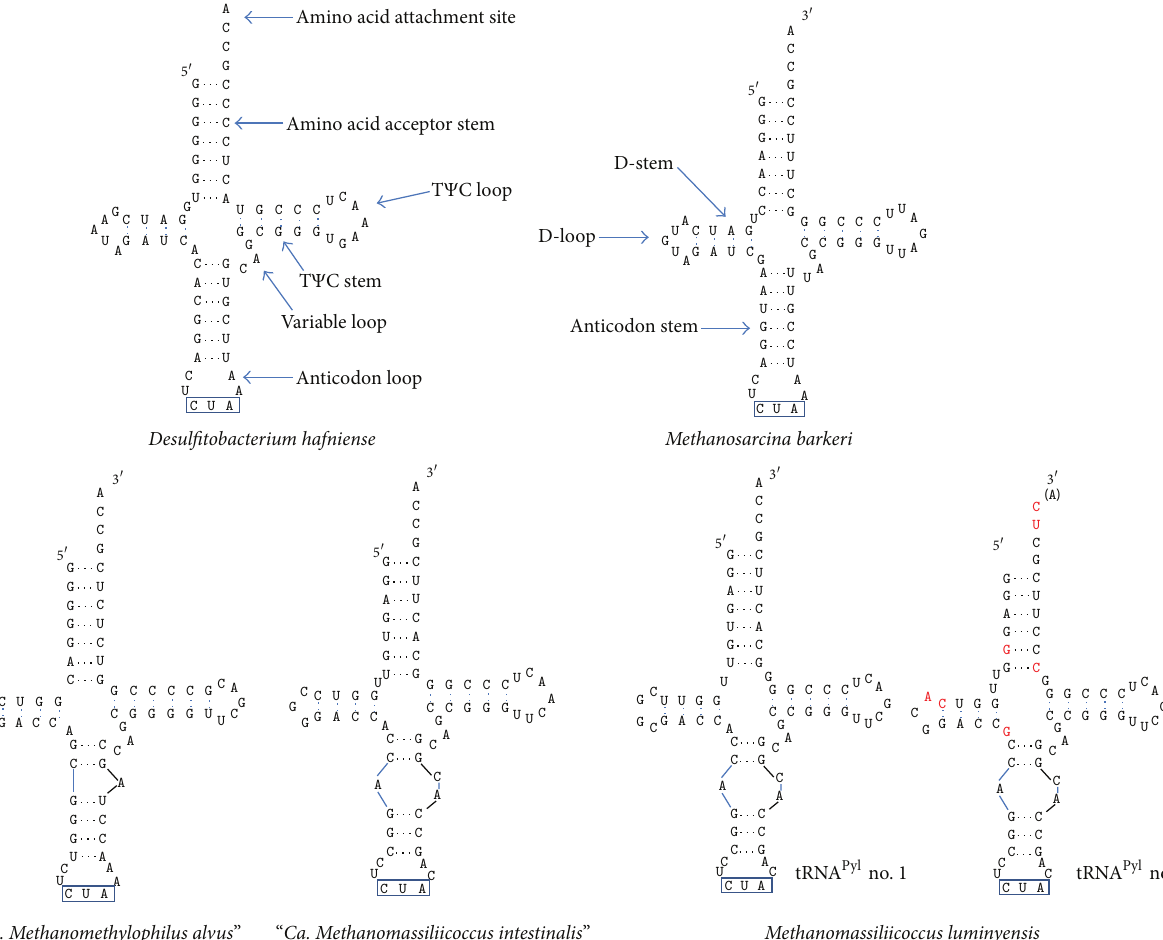
Figure 2: Secondary structure of the tRNA Pyl in the Thermoplasmata-related 7th order. The stem-loop structure of the tRNA Pyl in the 7th methanogenic order is shown, in comparison with the structure in bacteria ( Desulfitobacterium hafniense , left) and in Methanosarcinaceae ( Methanosarcina barkeri , right). The name of each region of the tRNA is indicated. The anticodon CUA (corresponding to the amber codon) is outlined in blue. For the two tRNA Pyl in M. luminyensis , the modified bases in no. 2 compared to no. 1 are written in red. Adapted and updated from [11,